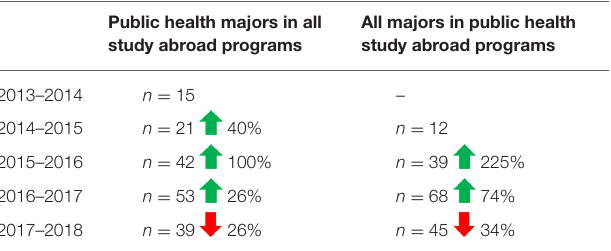
TABLE 2 | Study abroad